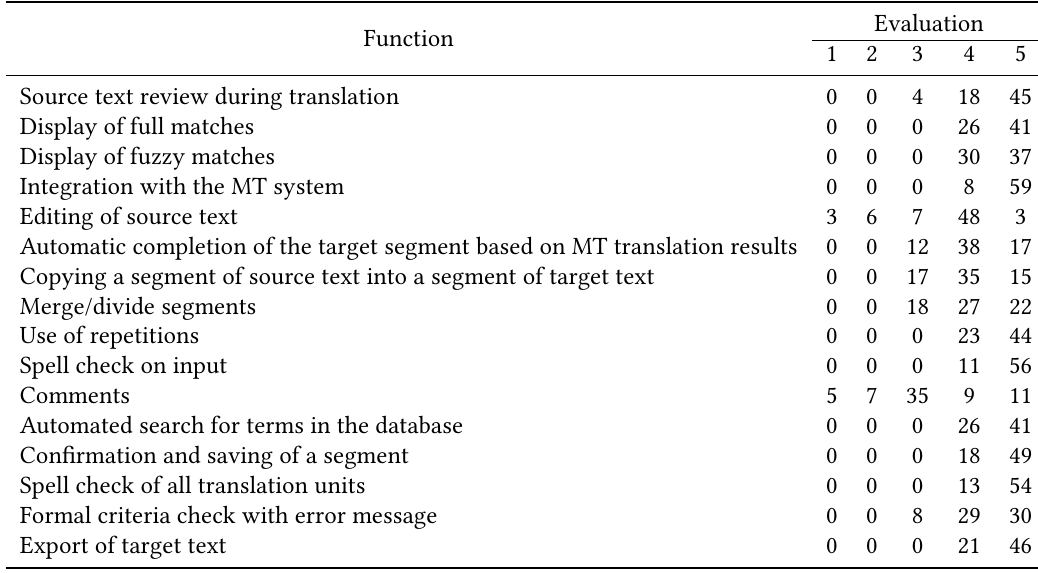
Table 1 Results of students’ evaluation of Memsource system functions.